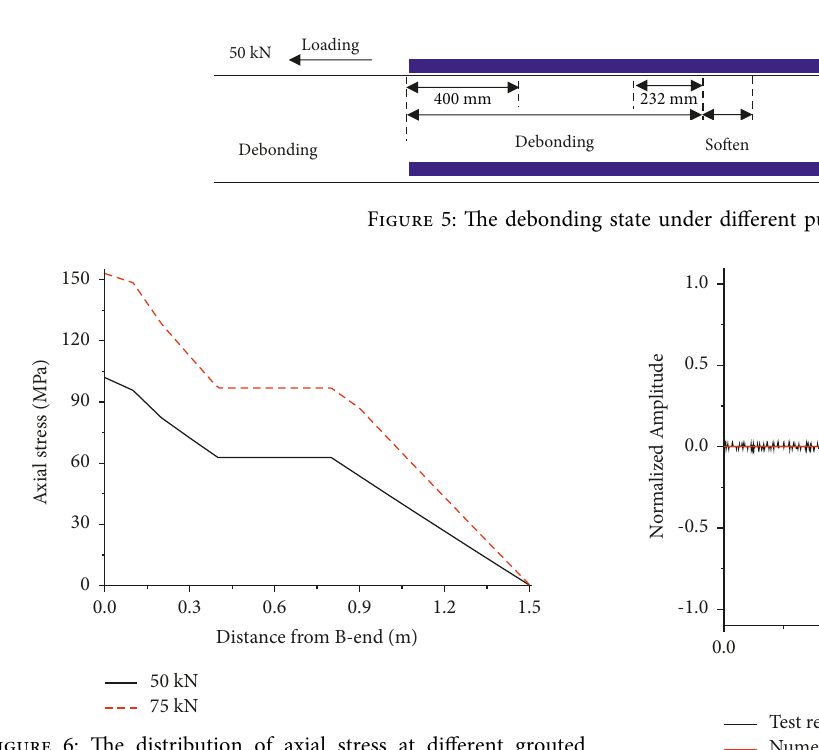
Figure 6: The distribution of axial stress at different grouted positions.